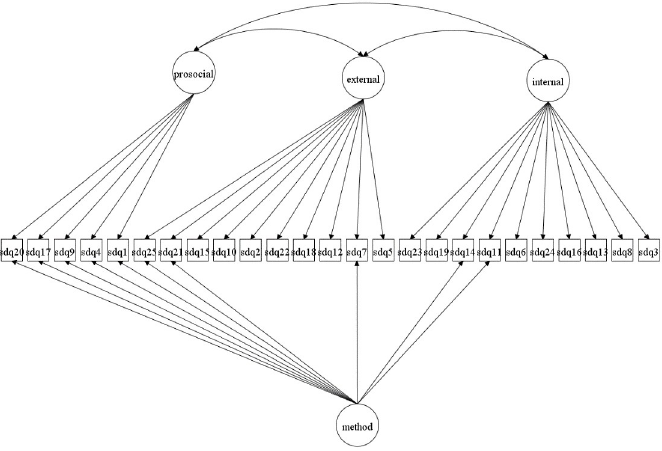
Fig 3. 3-factor model with a separate method factor (Model